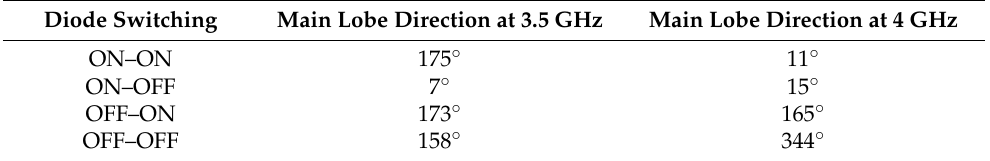
Table 3. Results for pattern-reconfigurable